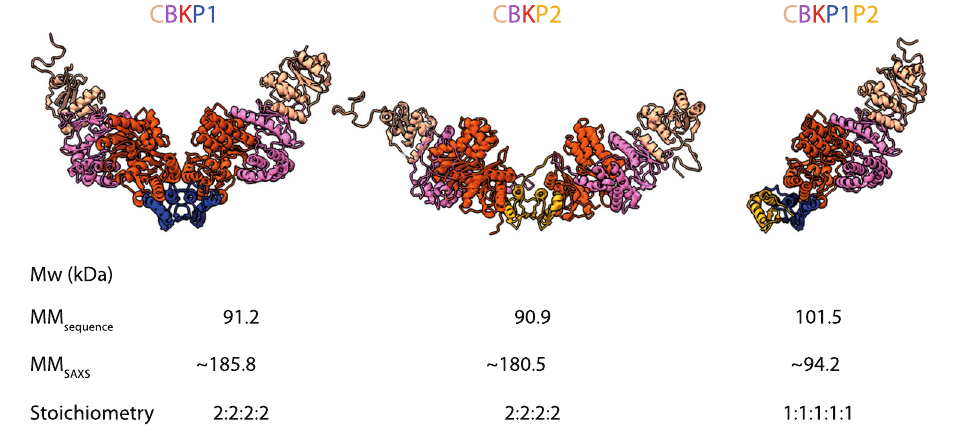
Fig. 6 | Model structures of PaKEOPS complexes. The structures of the three complexes modelled against the scattering data are shown. Calculated molecular mass from sequence and from scattering data and the deduced stoichiometry are indicated at the bottom. The subunits are colored as follows: Cgi121 (tan), Bud32 (violet), Kae1 (red), Pcc1 (blue), and Pcc2 (orange) CBKP1 and CBKP2 are dimers of